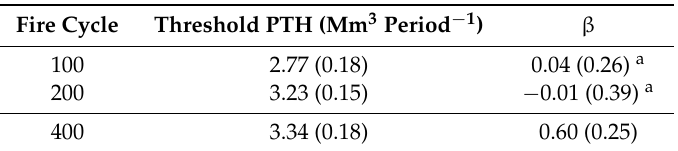
a Not significantly different from 0 at α = 0.05 ( p = 0.78 and p = 0.96, respectively). Numbers in parentheses represent a half-confidence interval.